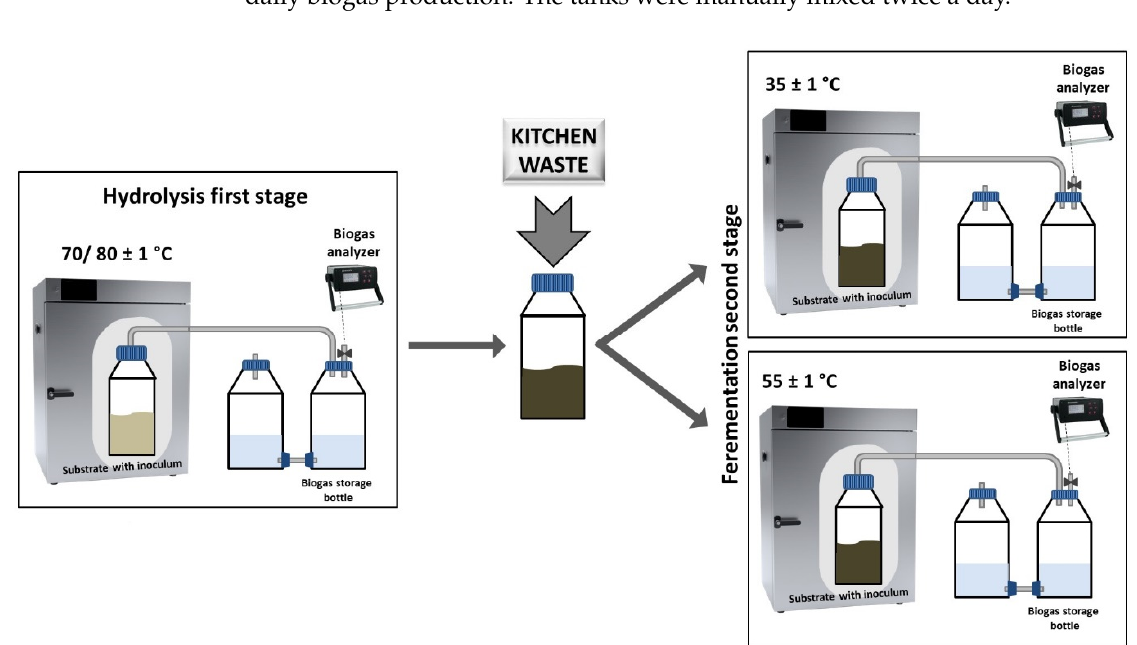
Figure 3. Laboratory setup used in the study.